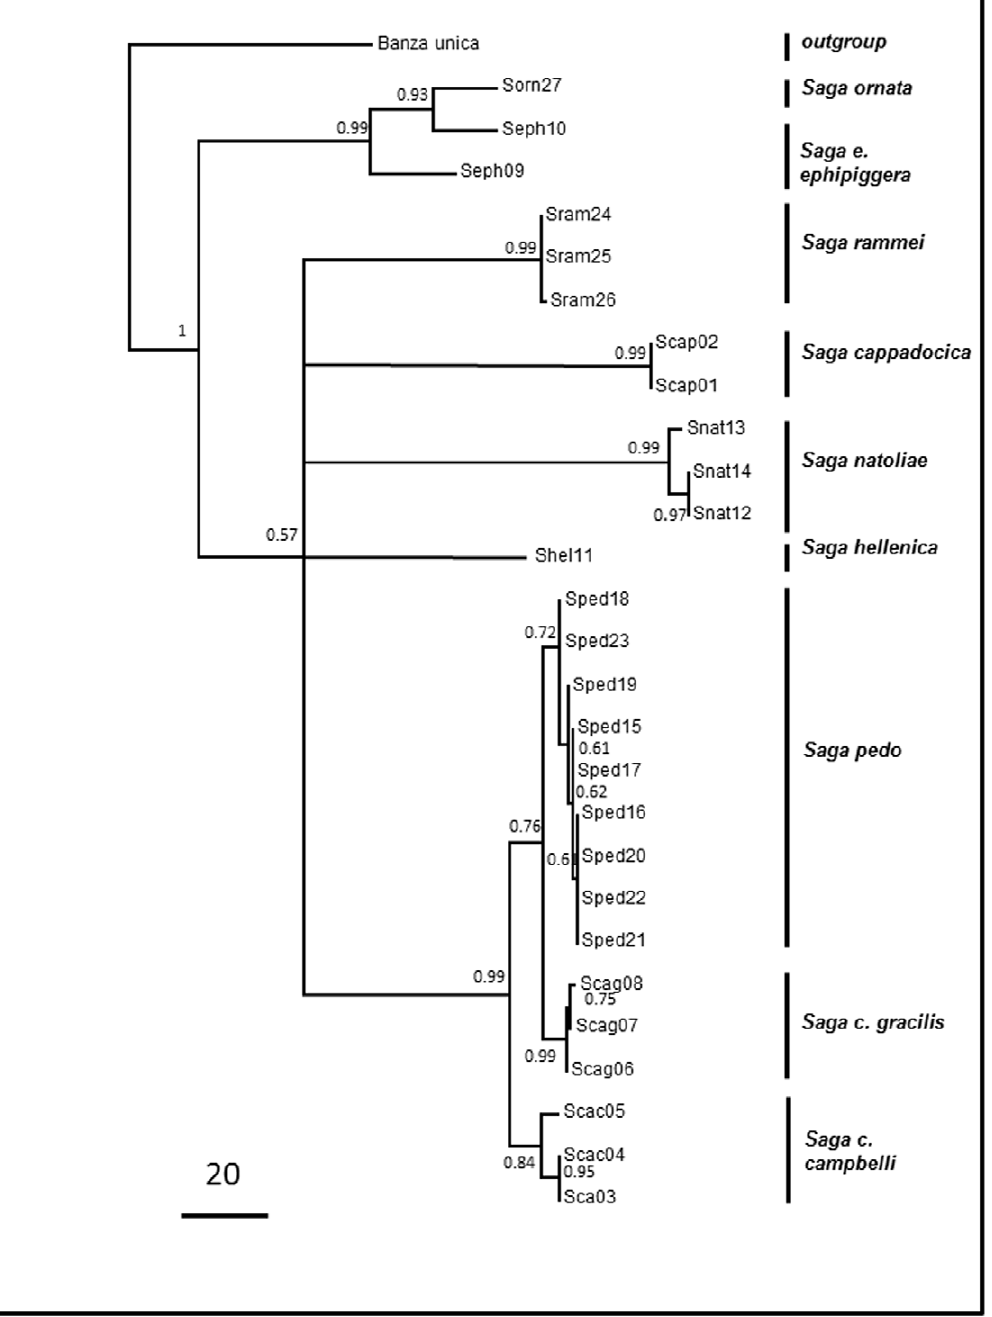
Figure 3. Maximum parsimony tree was inferred from combined mitochondrial ( cytb , cox I, 16SrRNA) DNA sequences of Saga species. The mitochondrial consensus tree was inferred from 20 most parsimonious trees (length=491). Branches corresponding to partitions reproduced in less than 50% trees were collapsed. The consistency index was 0.576, whereas the retention index was0.811. The composite index was 0.496for all sites and 0.468 for the parsimony-informative sites. There were a total of 641 positions in the final dataset, out of which 183 were parsimony informative. Numbers at each node indicate the MP bootstrap values. Vertical bars at right indicate the species. Banza unica was designated as outgroup. The MP tree showed that the phylogenetic relationship of S. pedo to S. c. gracilis is closer than that to S. c. campbelli. Although both methods have placed the basic clade ‘ephippigera- ornata’ closest to the outgroup, Bayesian analyses indicated a clear relationship among the rest of species with high bootstrap support values. Both analyses positioned B. unica as an outgroup, underlining the monophyly of the whole sampled Saga genus.